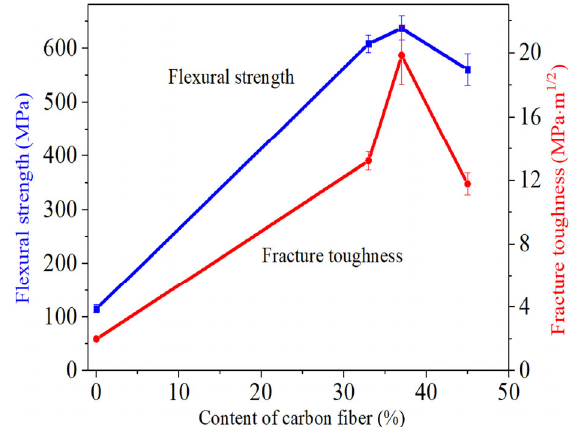
Fig. 4 Mechanical properties of C f /LAS composites with different carbon fiber content.